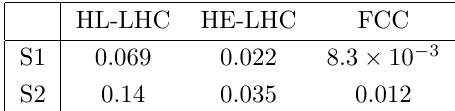
Table 3 . Coupling g Z 0 Y 0 for which a signal can be seen with 5 (cid:27) signi(cid:12)cance at future colliders. q